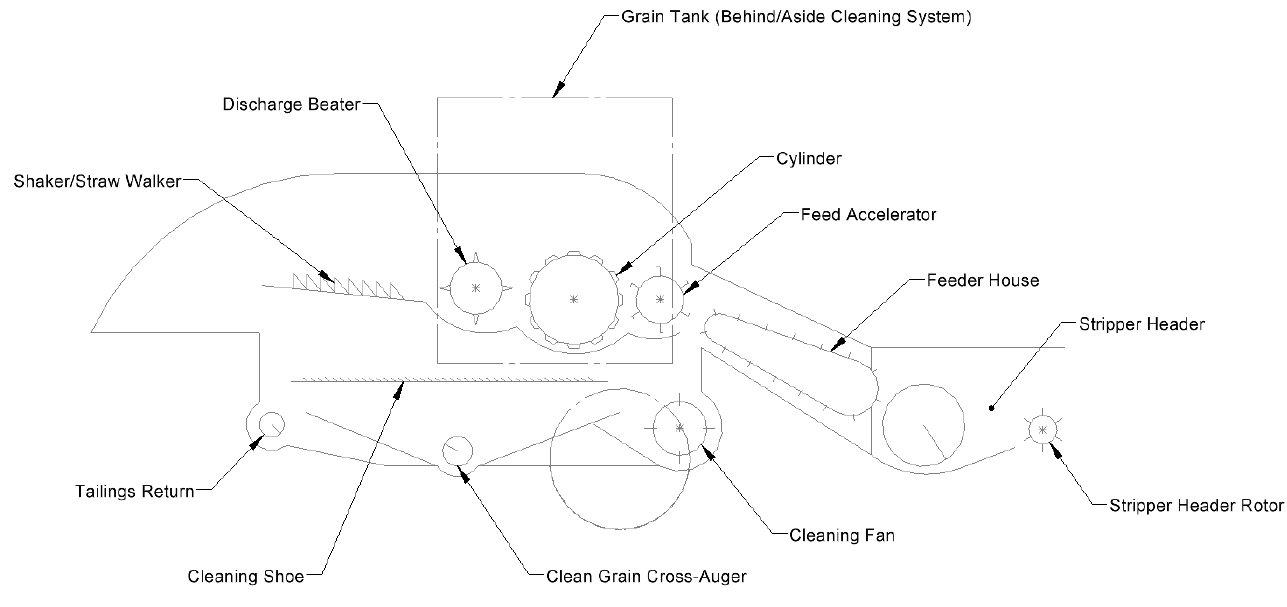
Figure 1. Schematic dia gram of the Oliver 18 combine harvester with principal components.